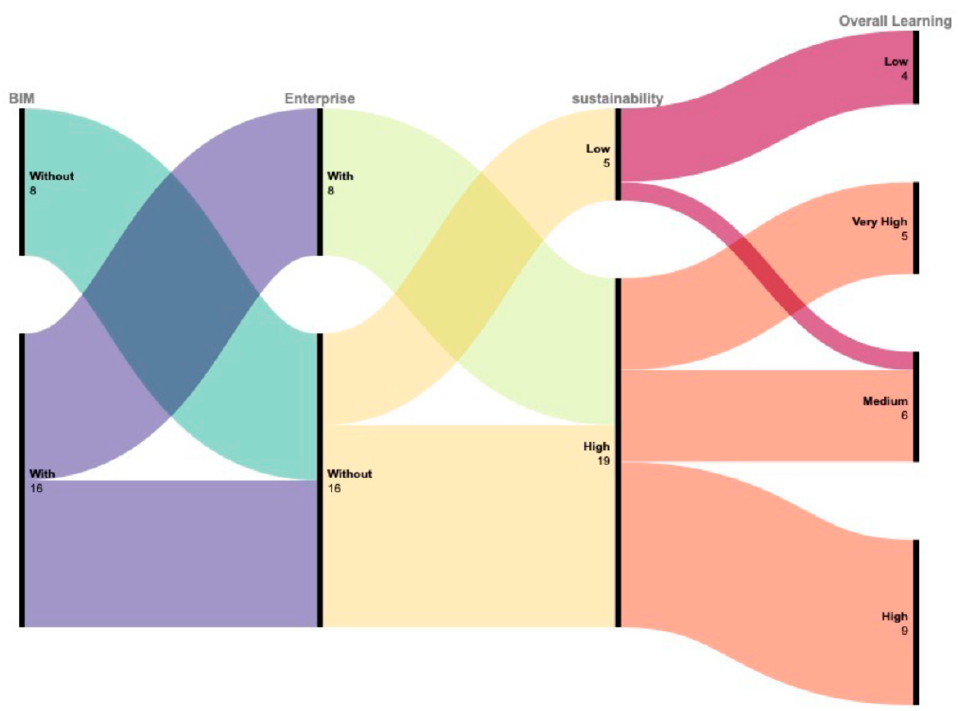
Figure 6. Academic Evaluation: Alluvial Diagram (score < 2: low, scores 2 to 3: medium, scores 3 to 4: high, scores ≥ 4: very high. Data displayed graphically using RAWGraphs [45]).